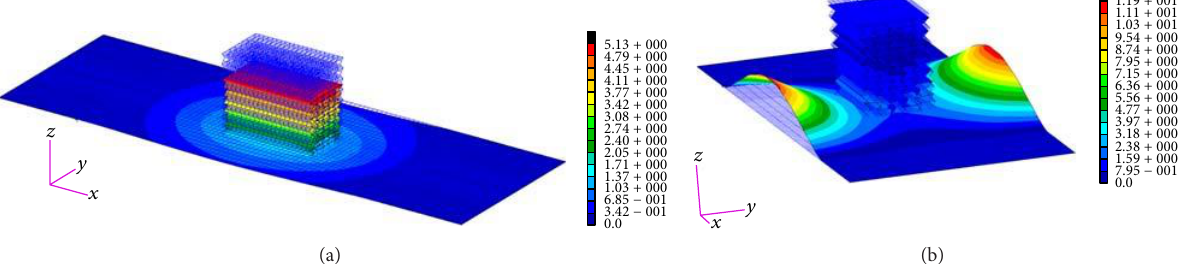
Figure 23: Two-node vertical mode shape of the control base with the FEM: (a) mode shape of the auxetic cellular base and (b) mode shape of the steel grillage.